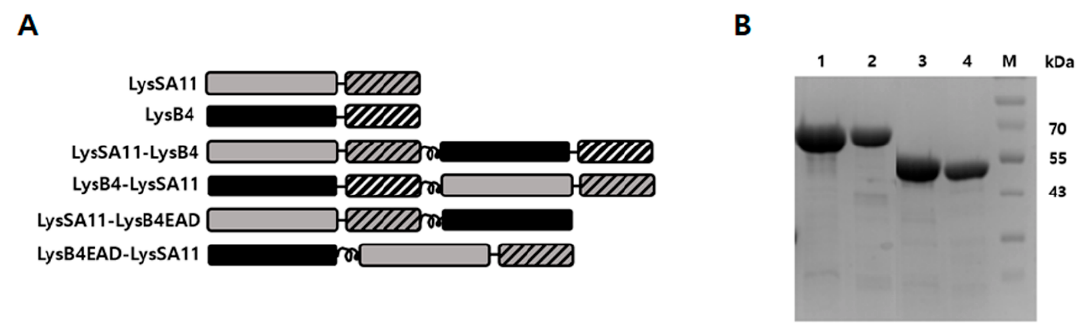
Figure 1. The modular structure of hybrid proteins and their lytic activity. ( A ) Schematic representation of LysSA11, LysB4, LysSA11-LysB4, LysB4-LysSA11, LysSA11-LysB4EAD, and LysB4EAD-LysSA11. LysSA11EAD: gray box; LysSA11CBD, gray diagonal stripe; LysB4EAD, black box; LysB4CBD, white diagonal stripe. ( B ) Purified LysSA11-LysB4, LysB4-LysSA11, LysSA11-LysB4EAD, and LysB4EAD-LysSA11 were loaded on an SDS-PAGE gel. Lane 1, purified LysSA11-LysB4 fraction; lane 2, purified LysB4-LysSA11 fraction; lane 3, purified LysSA11-LysB4EAD; lane 4, purified LysB4EAD-LysSA11 fraction; lane M, molecular weight marker.